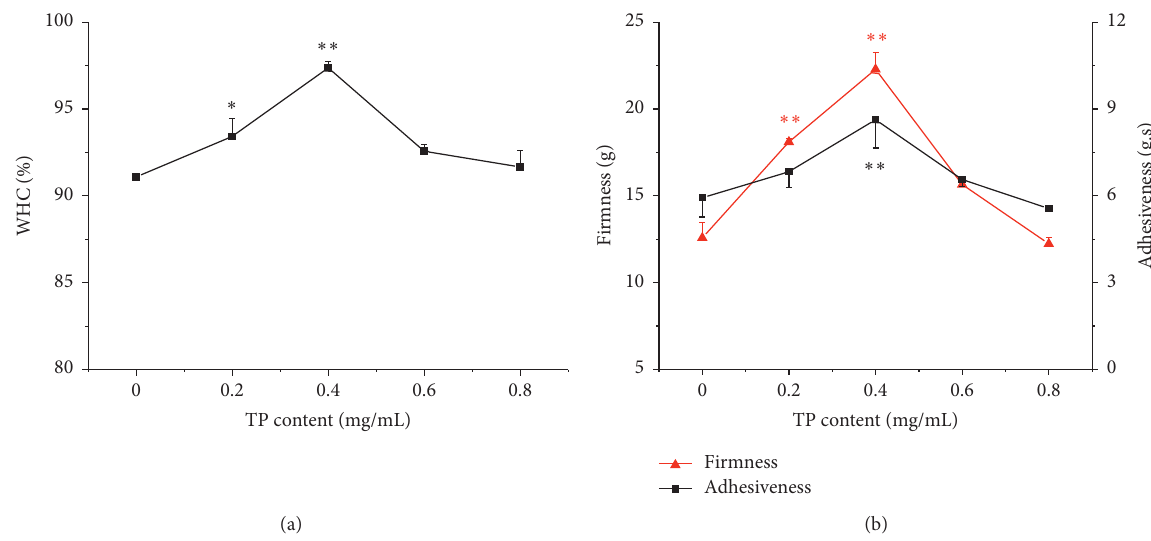
Figure 5: Co-supplementing different contents of TP with 2.4% FSE influenced on WHC (a) and textural properties (b) of low-fat yogurts. ∗ Significant difference at p < 0 . 05; ∗∗ significant difference at p < 0 . 01 compared with FSE2.4. FSE: Flos Sophorae extract; TP: Tremella fuciformis polysaccharides; WHC: water holding